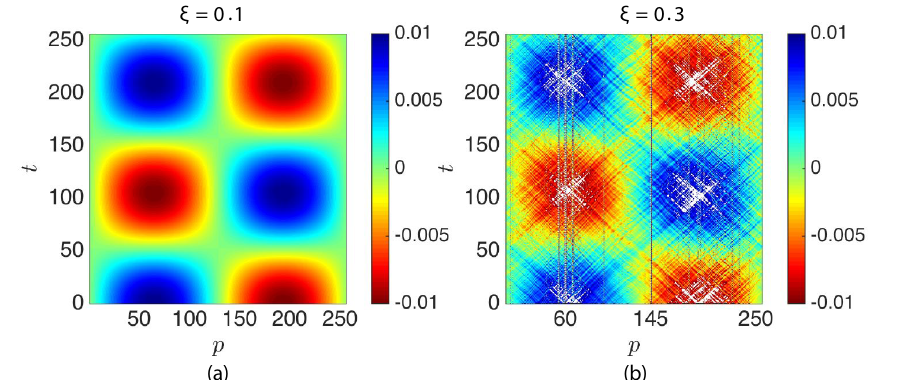
Figure 9. Sinusoidal standing wave ( a ) u ( p ) ( t ) ( p = 1 to 256) of an ordered granular chain ( ξ = 0.0). ( b ) u ( p ) ( t ) of a disordered granular chain ( ξ = 0.3), while color indicates the largest displacements; white patterns are amplitudes outside the color